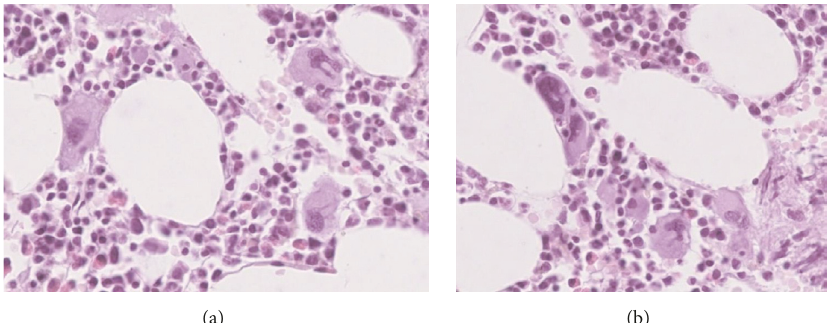
Figure 3: Trephine biopsy revealed normocellular bone marrow without fibrosis with normal differentiation of granulocytic and erythroid lineage. A marked increase in megakaryocytic density was present. Megakaryocytes presented with moderate pleomorphism, most cells showing nuclear hyposegmentation with normal nuclear to cytoplasmic ratio (a) and a few myeloproliferative hypersegmented and atypical forms. Moreover megakaryocytic lineage displayed focal aggregation